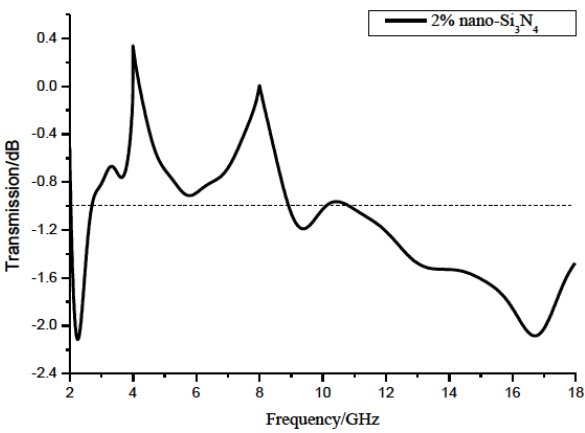
Figure 5: Absorbing reflectivity of the matching layer doped with 2% nano-Si 3 N 4